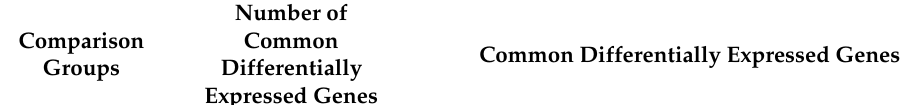
Merino vs. (Poll Dorset and Dohne)